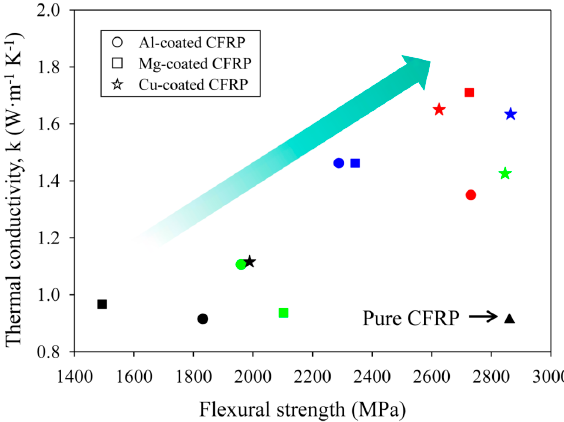
Figure 7. Through-thickness thermal conductivity of CFRP composites coated with three types of inorganic crystal filler against the flexural strength. The four colors refer to different weight fractions of fillers—red: 0.01 wt %; blue: 0.1 wt %; green: 0.2 wt %, black: 0.4 wt %.